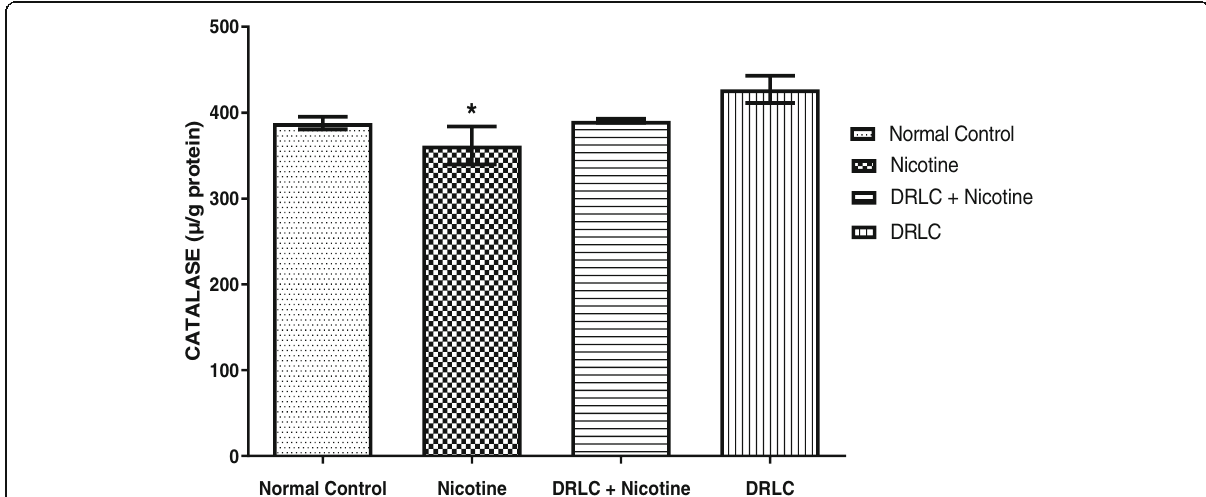
Fig. 2 Charts showing CAT levels in the testes of experimental animals. Values are mean ± SEM; N = 5. *Statistically different from DRLC group (p < 0.05)